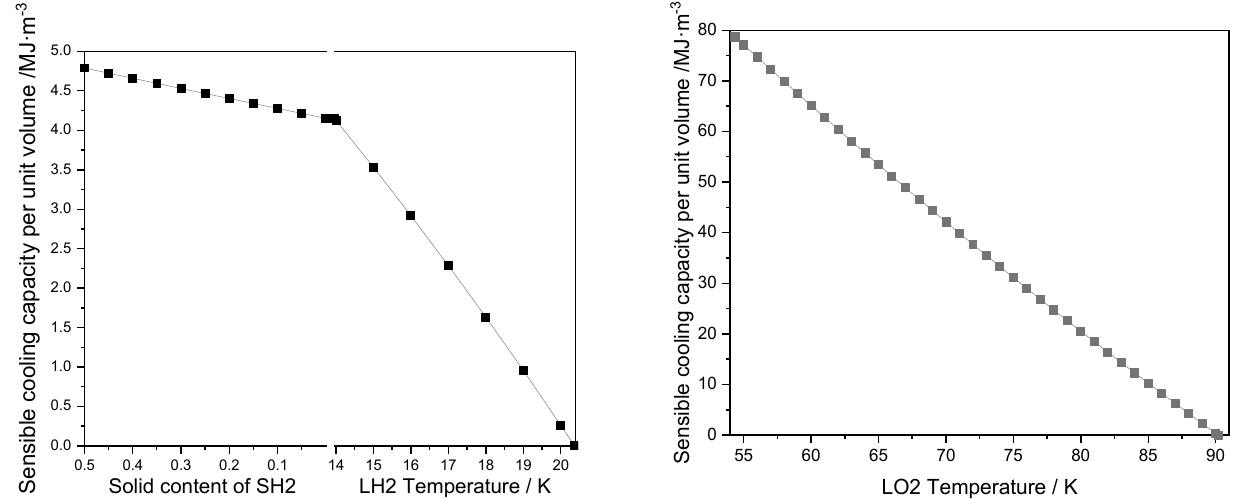
Figure 10. Relationship between LH2/LO2 densification degree and the sensible cooling capacity per unit volume.